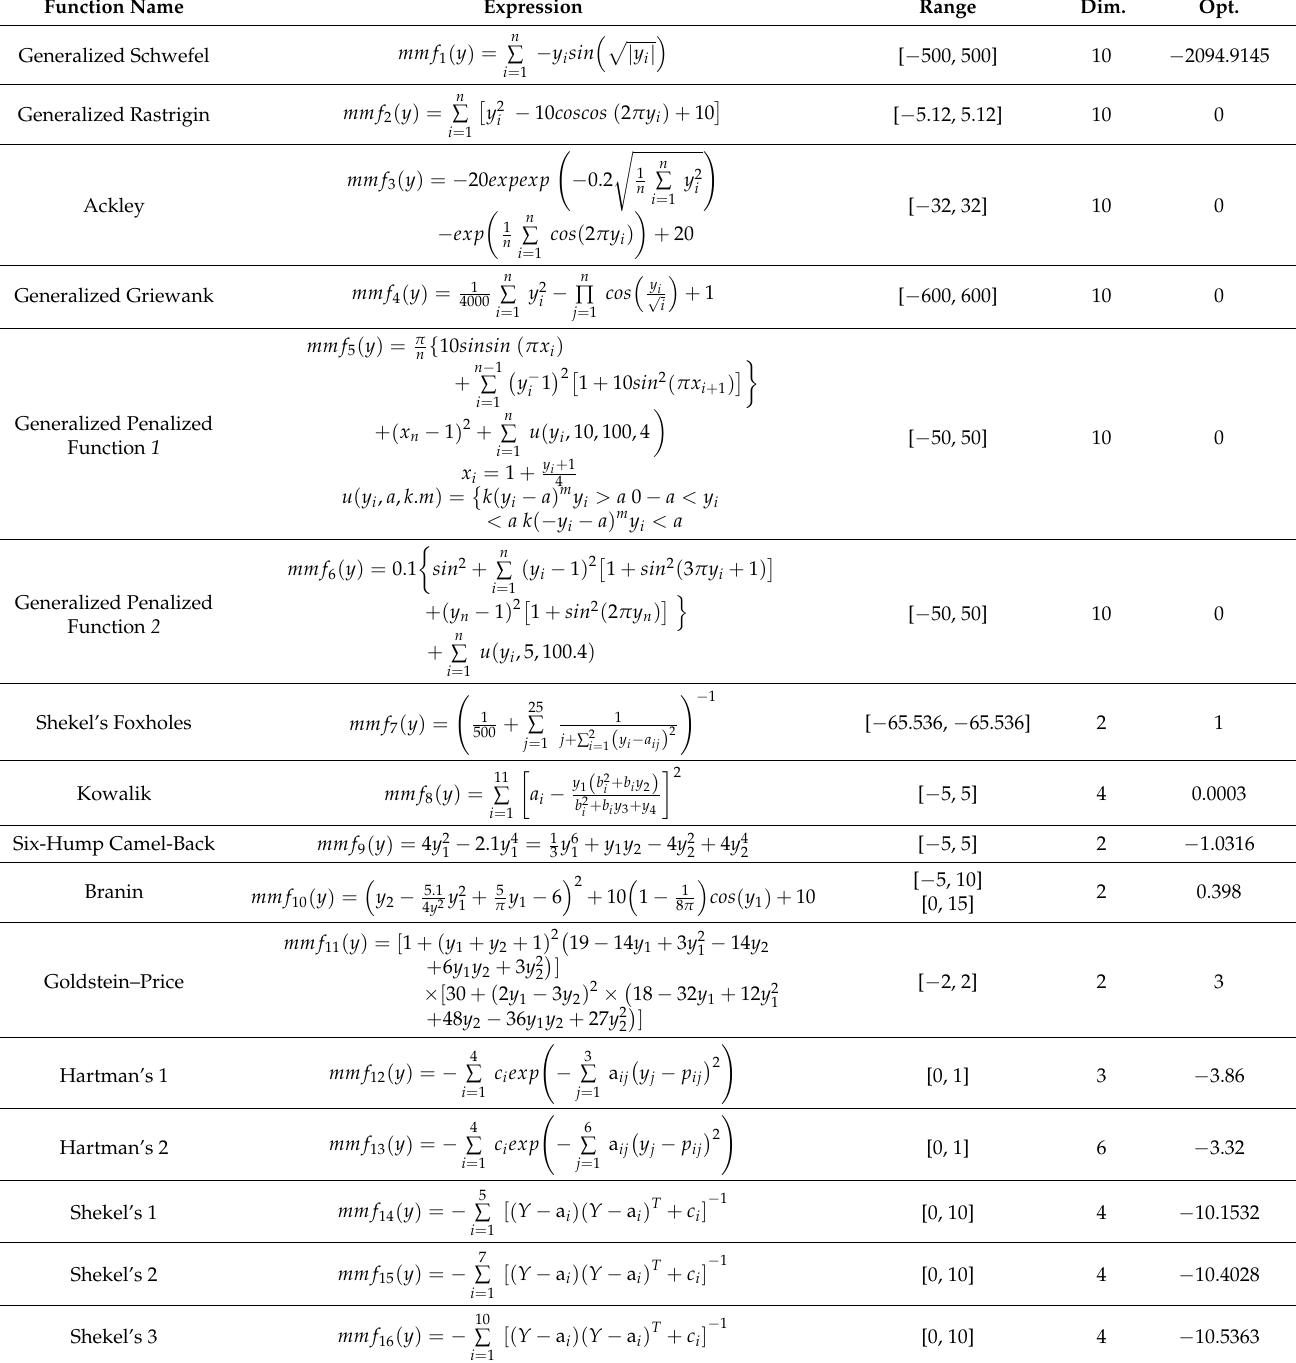
Table 2. Multimodal